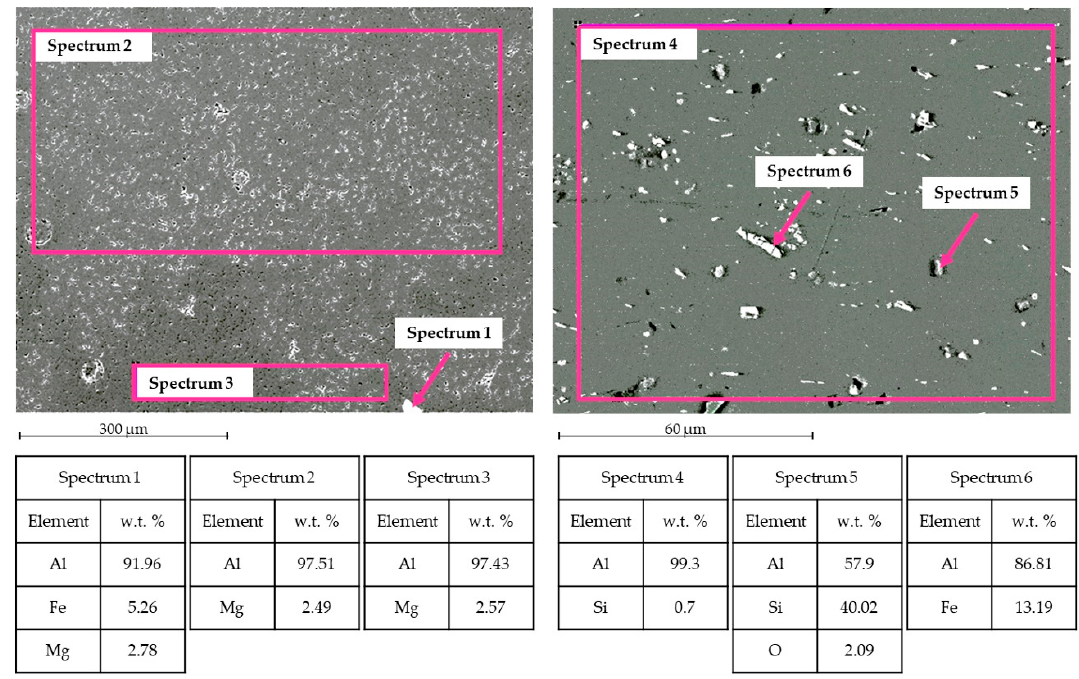
Figure 8. TIG welding analysis. Left side: SEM image and EDS in WZ. Right side: SEM image and EDS in HAZ.